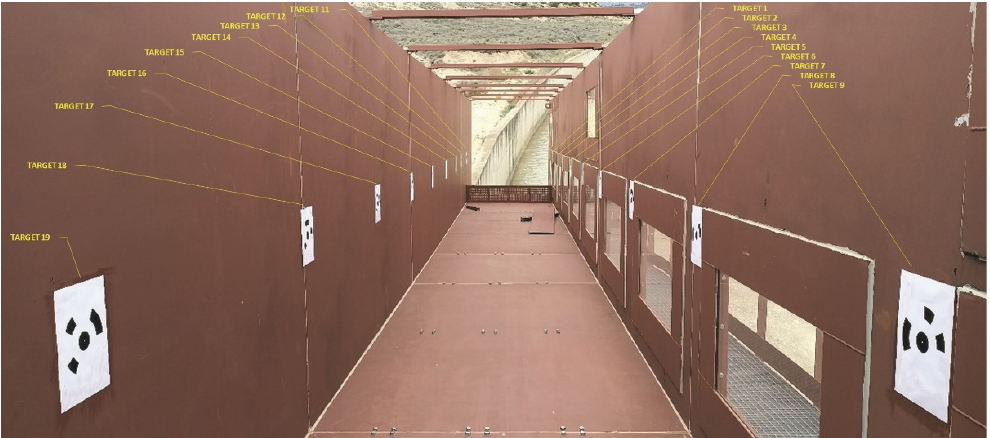
Figure 11. Picture of the targets on the sides of the testing chute.